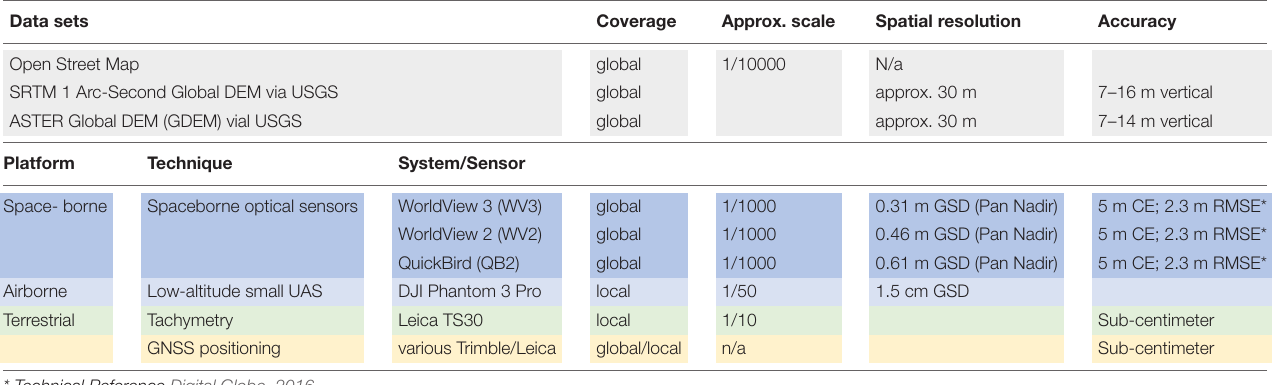
TABLE 1 | Available data sets and sources with spatial resolution, coverage and accuracy.